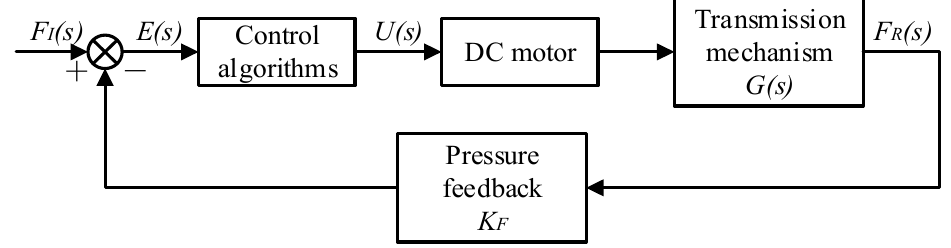
Figure 14. Control system structure drawing.